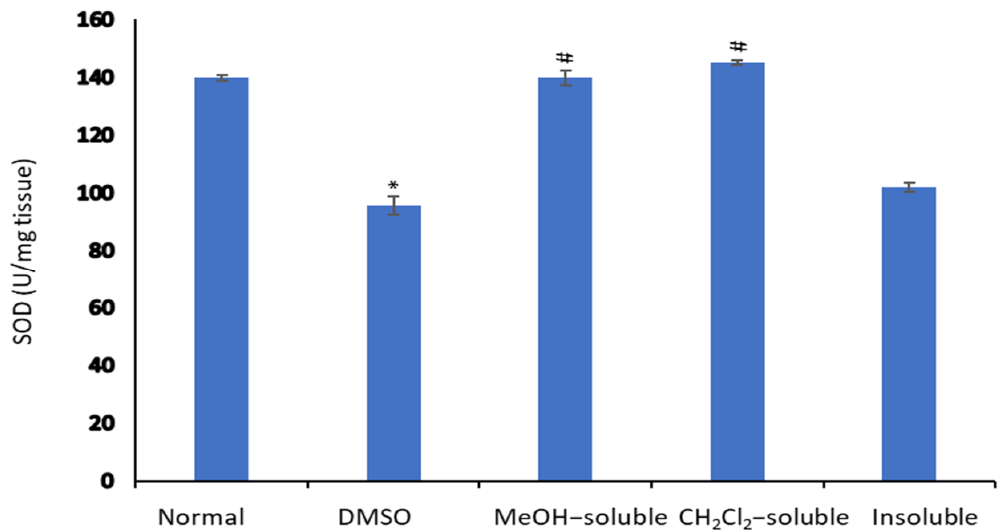
Figure 6. Effect of A. zerumbet extracts (MeOH, CH 2 Cl 2 , and insoluble) on superoxide dismutase (SOD) activity. SOD levels were assessed in liver homogenate, data was represented as mean ± SEM and expressed as U/mg tissue. Significantly (* p < 0.001) different from the normal control (untreated) and significantly ( # p < 0.001) different from the vehicle control (tumor + DMSO).